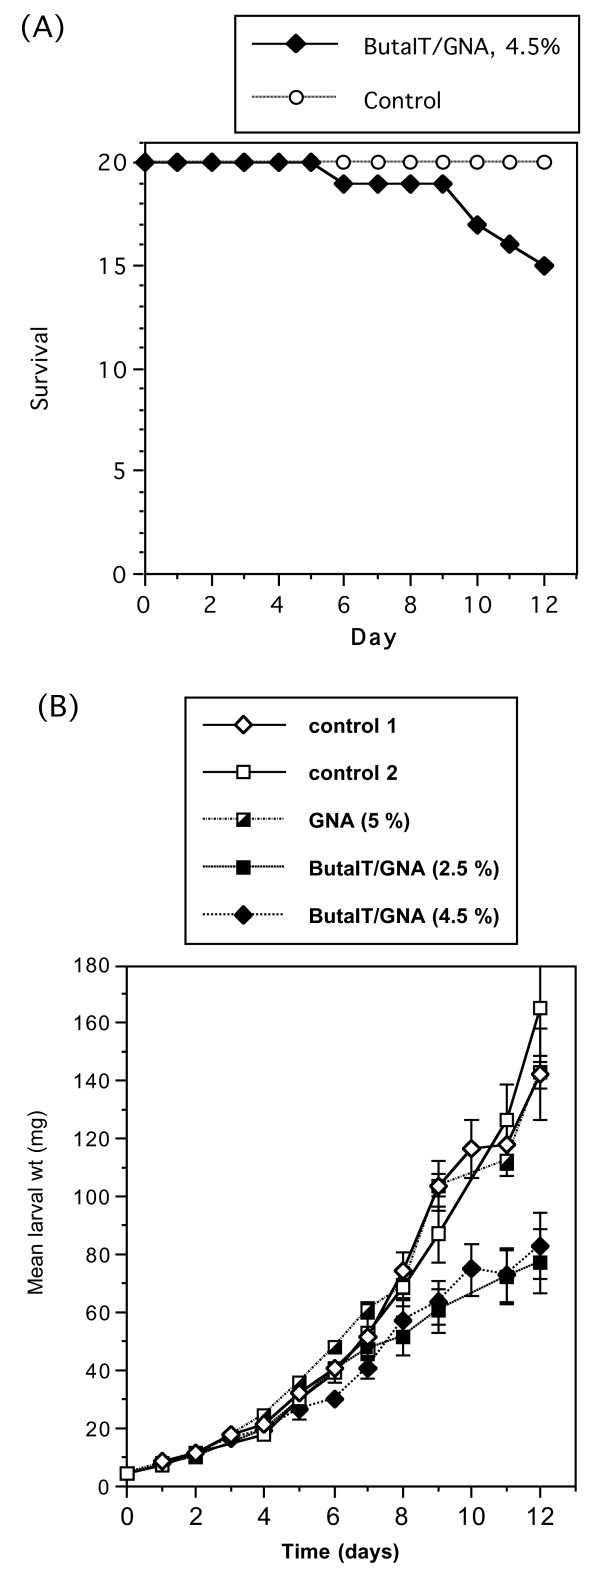
Survival and weight gain for L. oleracea larvae fed diets containing purified recombinant proteins. (A). Survival of third stadium L. oleracea larvae fed for 12 days on control diet or diets containing recombinant ButaIT/GNA at 4.5 % dietary protein. (B) Mean weight of third stadium L. oleracea larvae fed for 12 days on control diet or diets containing recombinant ButaIT/GNA at 4.5 % and 2.5 % dietary protein, or recombinant GNA at 5 % dietary protein. Data has been combined for 2 assays carried out under the same conditions, and thus data for two control treatments is provided. n = 20 per treatment (control total n = 40). Points and bars denote mean ± SE.